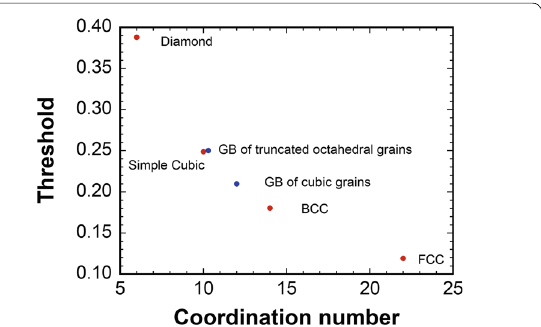
Fig. 8 Threshold for bond percolation as a function of coordination number. Threshold values for diamond, simple cubic, body-centered cubic (BCC) and face-centered cubic (FCC) lattices are 0.388, 0.2488, 0.1803 and 0.119, respectively (Stauffer and Aharony